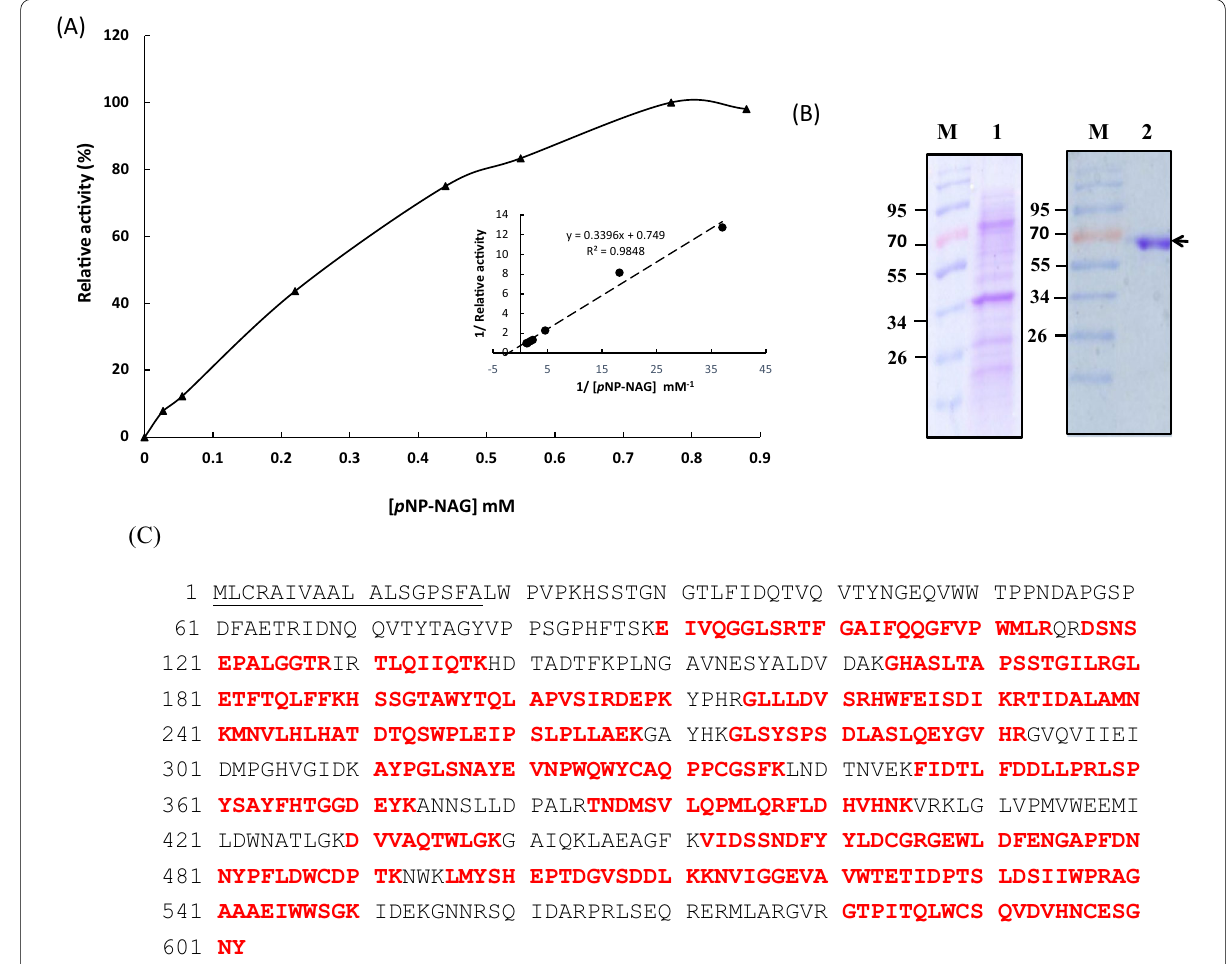
Fig. 2 Kinetic parameter and SDS‑PAGE analysis of TvmNAG2, and protein sequence of TvNag2. A The activity of TvmNAG2 was determined using different concentrations of substrate, p NP‑NAG. Michaelis–Menten and Lineweaver–Burk graphs were then plotted. B SDS‑PAGE analysis: lane 1, the crude protein from the precipitation of 8‑days T. virens filtrate with 80% (NH 4 ) 2 SO 4 ; lane 2, the affinity‑purified TvmNAG2; M, protein marker. C TvmNAG2, lane 2 from B , was matched to T. virens Gv29‑8 Nag2 (TvNag2, accession number, XM_014099474) after MALDI/MS analysis. The matched peptides of TvmNAG2 were marked in